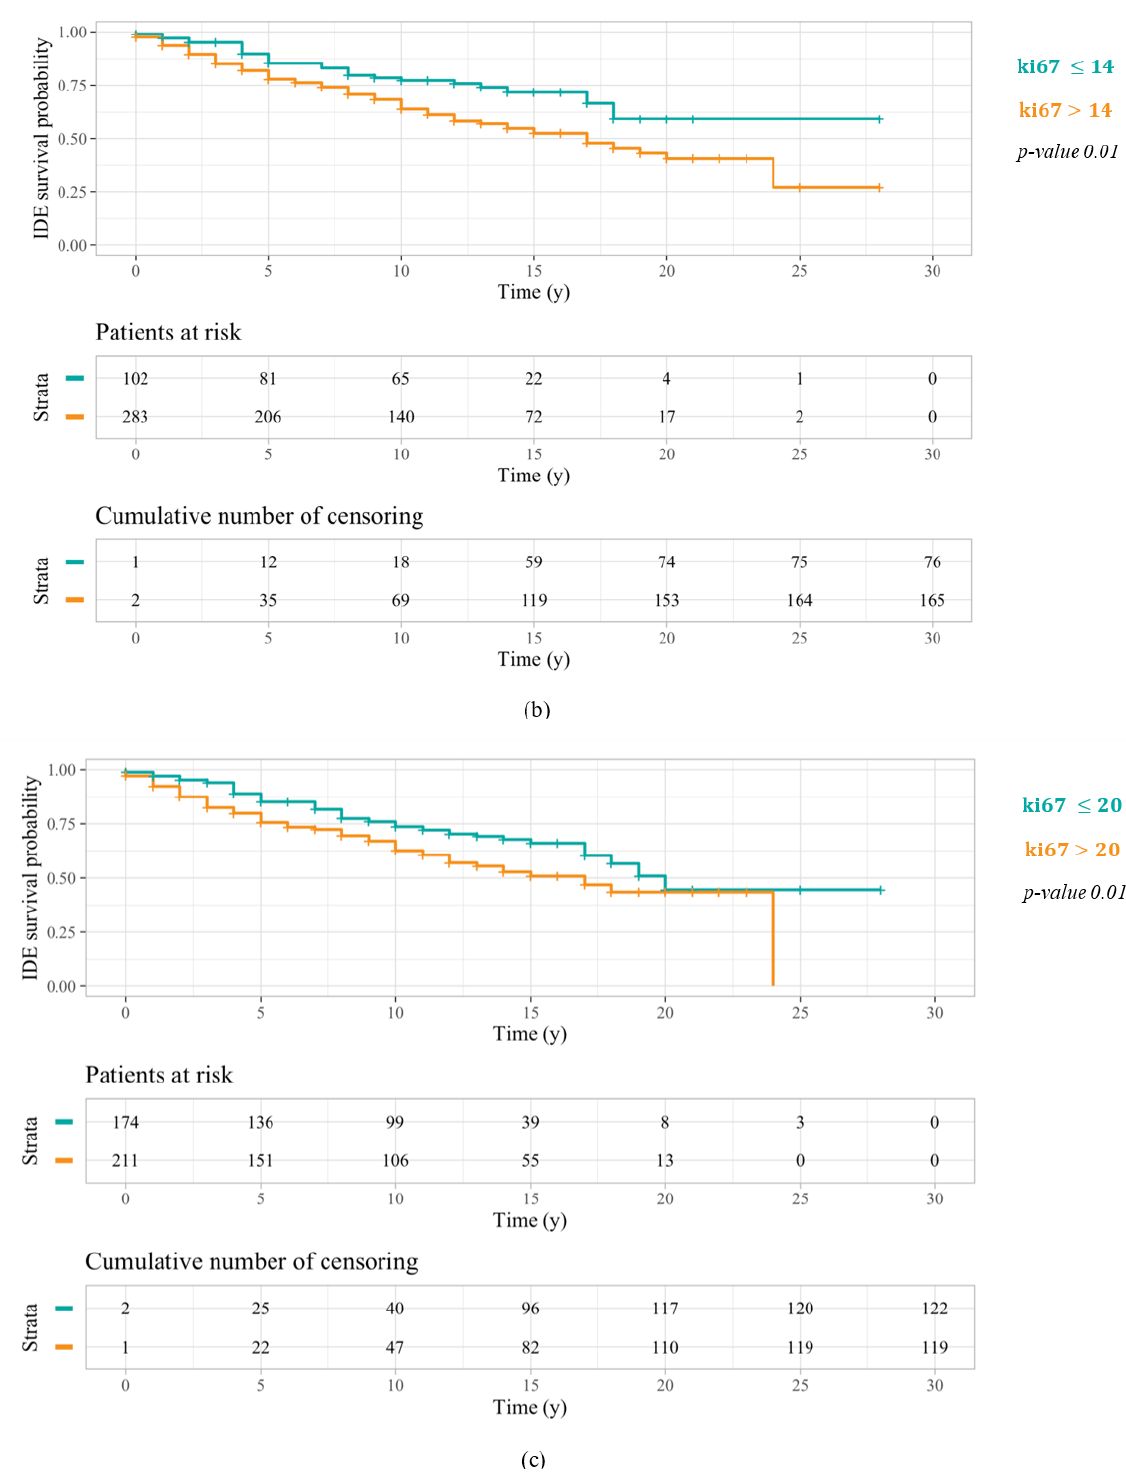
Figure 1. IDEFS curves related to a Kaplan–Meier analysis performed on patients under 50 years old with respect to the three different ki67 threshold values: 10% ( a ), 14% ( b ), and 20% ( c ). The log-rank test p -values highlighted a greater significance of the first